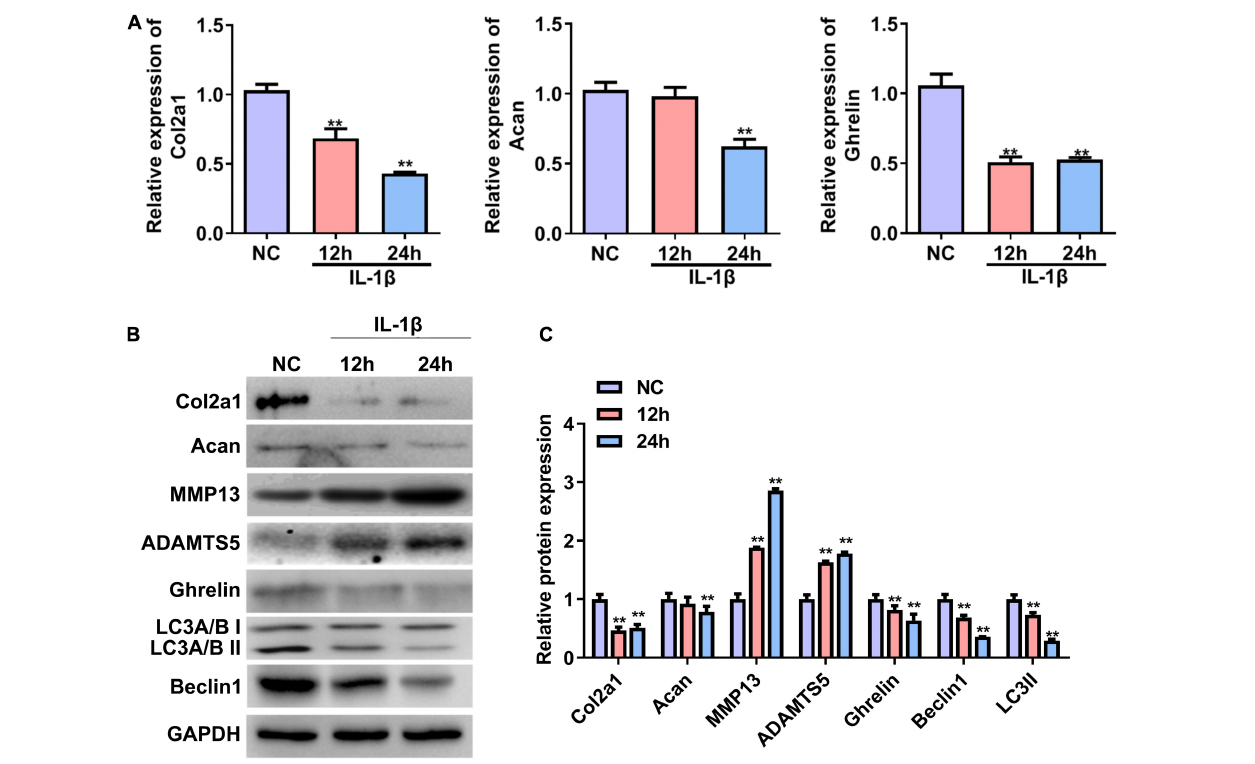
FIGURE 1 | Expression of the ghrelin, autophagy-related markers, and cartilage matrix markers in rat chondrocytes stimulated with IL-1 β . (A) Relative mRNA levels of the Col2a1, Acan, and ghrelin in rat chondrocytes after IL-1 β stimulation. RT–qPCR was used to determine mRNA levels. (B) Western blotting results of the Col2a1, Acan, ghrelin, MMP13, ADAMTS5, beclin 1, LC3, and GAPDH in chondrocytes stimulated with IL-1 β . (C) Quantification of the proteins shown in (B) . RT–qPCR, quantitative real-time polymerase chain reaction; NC, normal control; IL-1 β , interleukin-1 β ; Col2a1, collagen 2a1; Acan, aggrecan; MMP13, matrix